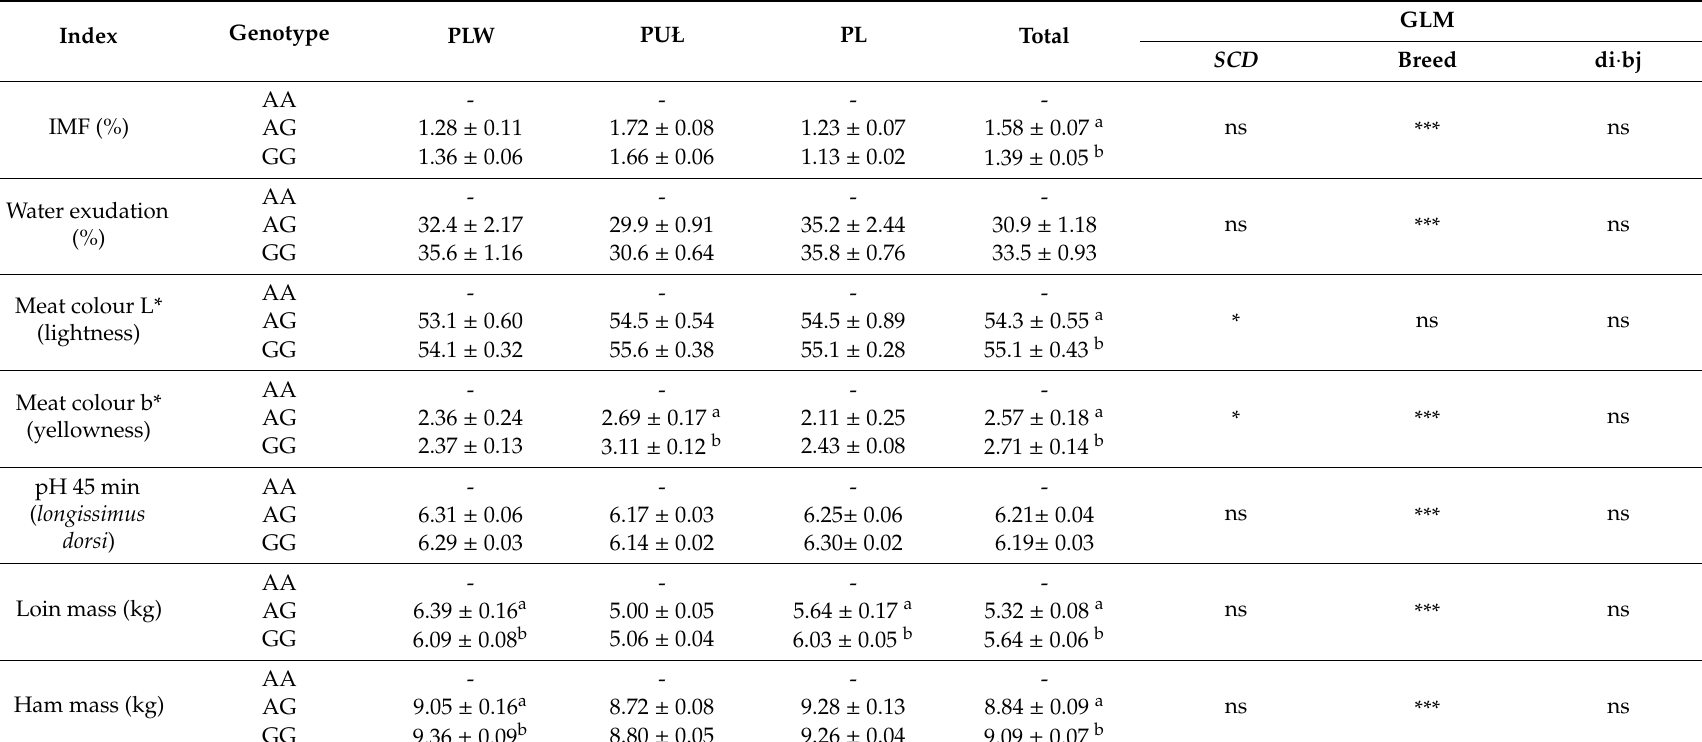
Table 4. Association of SCD mutation and analysed traits (LSM ±